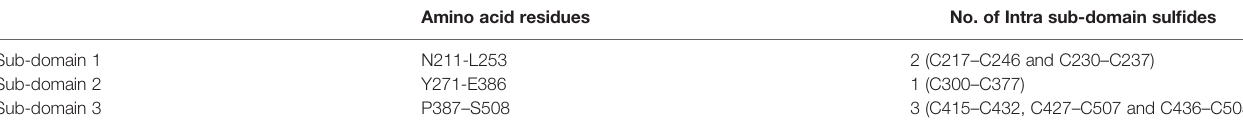
TABLE 2 | Pv DBPII separated into 3 sub-domains.